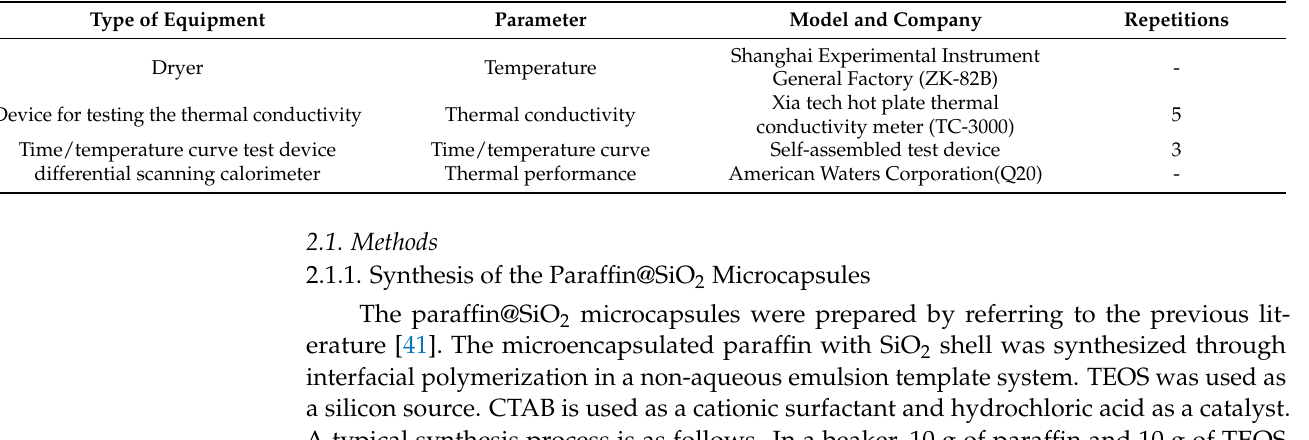
Table 3. Laboratory equipment used to perform the